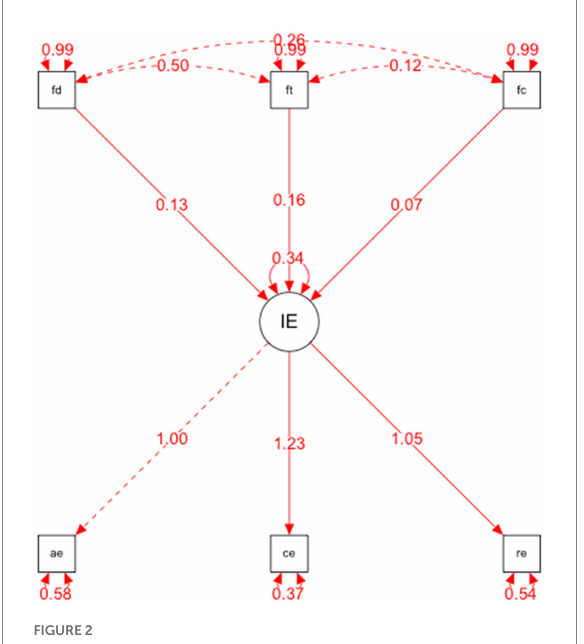
FIGURE 2 Structural equational